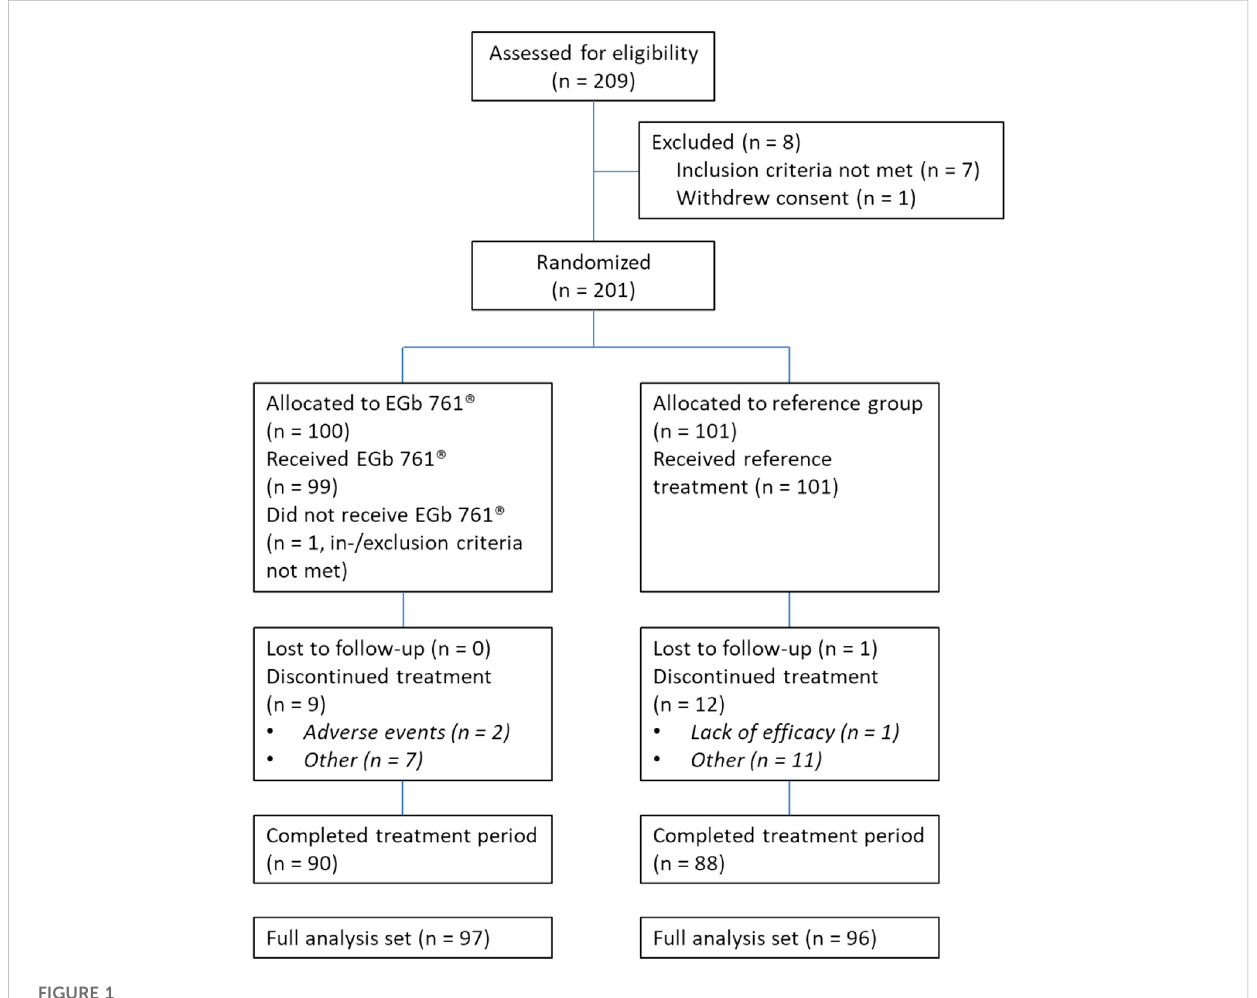
FIGURE 1 Patients fl ow